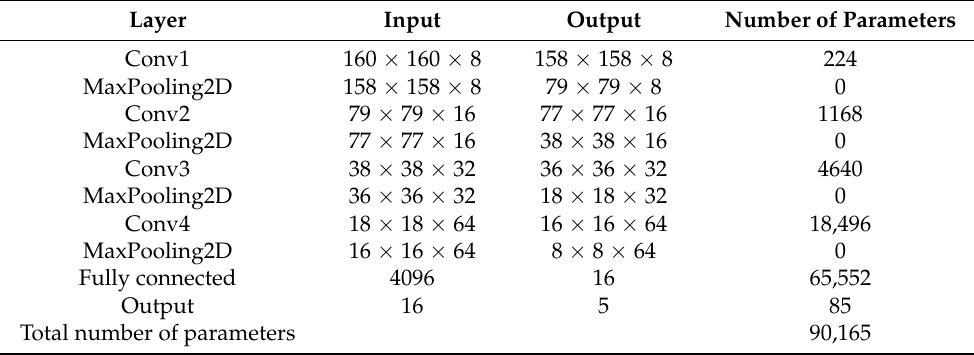
Table 1. Model Summary of CNN.